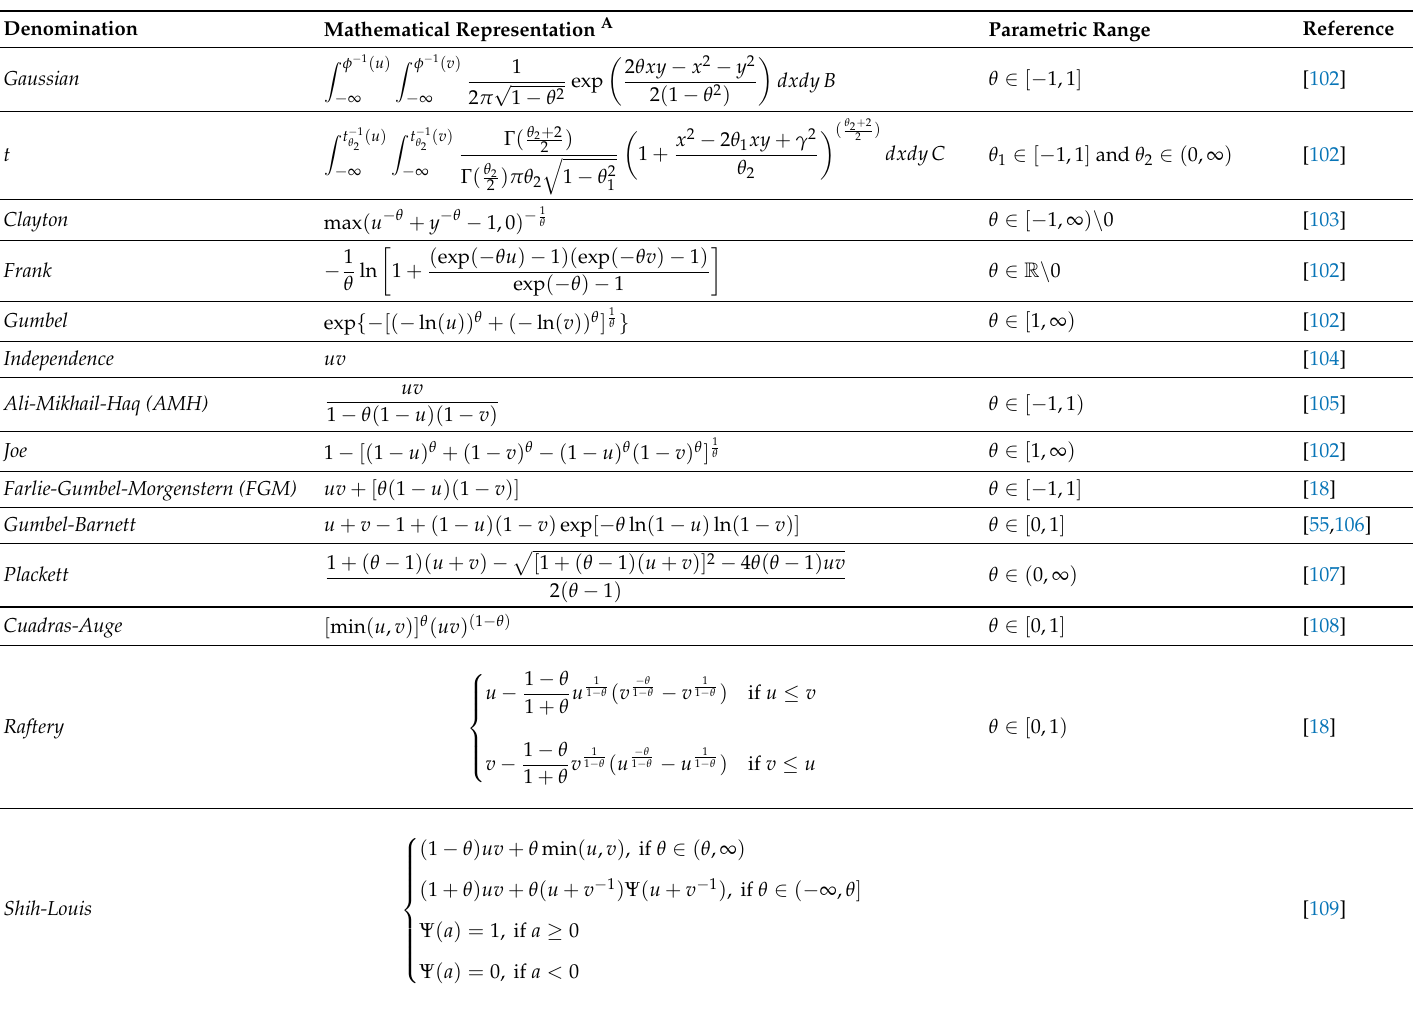
Table 2. Families of copulas used in this analysis, specifying their corresponding most common mathematical